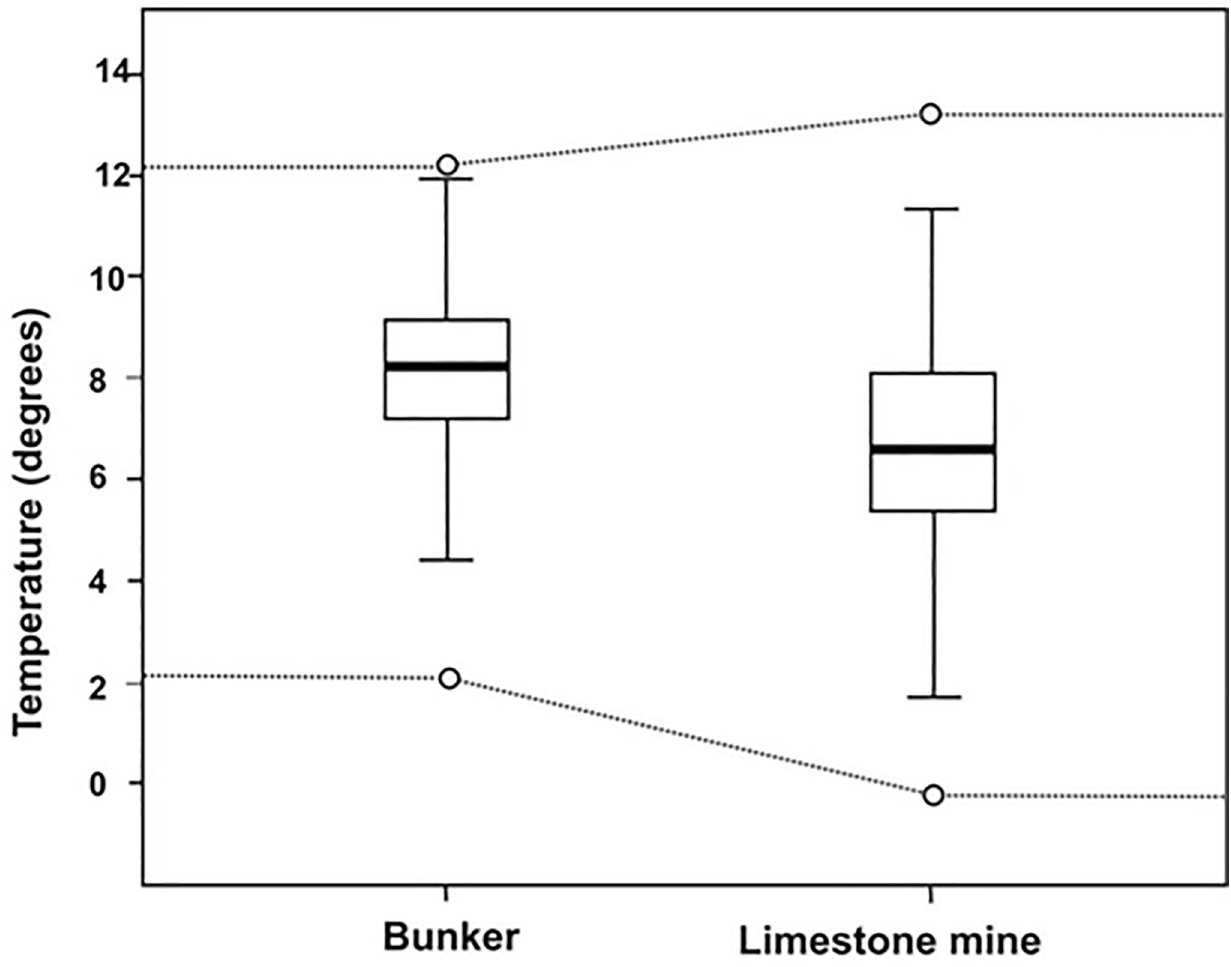
Fig 3. Boxplot showing the microclimate range in the hibernacula and the microclimate near hibernating pond bats in bunkers (54 sites, 1,072 observations near pond bats) and limestone mines (32 sites, 401 observations near pond bats). The box plots show the 25–75 percentiles (box), the 10 and 90 percentile (T). The line within the box indicates the mean. The broken lines indicate the observed temperature range inside both hibernaculum types (1,578 bunker and 1,406 limestone mine temperature observation points).